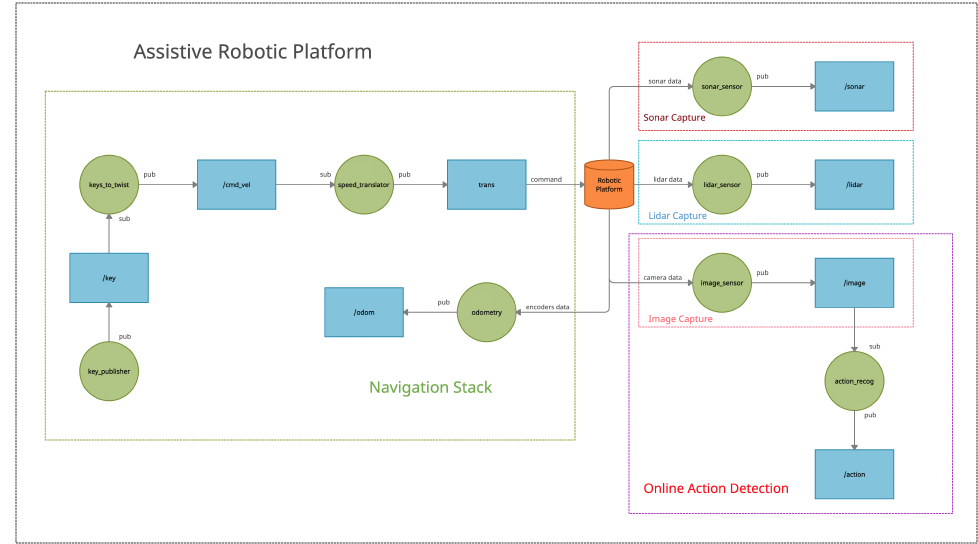
Figure 2. Robotic Operating System (ROS)-based complete software